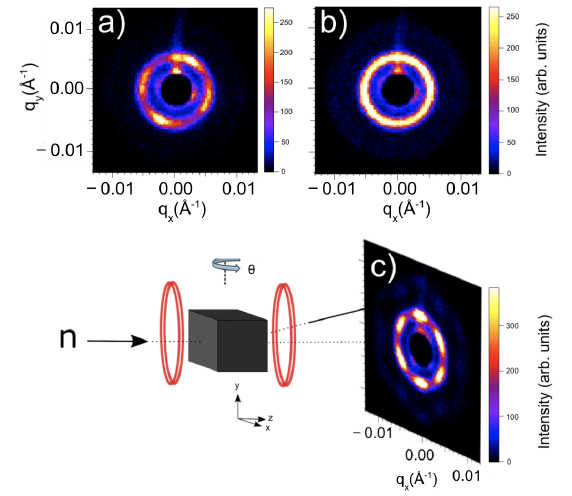
Figure 8. SANS images showing the disordered helical ground state at room temperature in zero field ( a ); the initial scattering ring for disordered skyrmion domains at 310 K in a magnetic field of 250 Oe ( b ); a schematic of the symmetry-breaking field rotation setup; and the SANS image after 30 rotations of the rotation sequence at 310 K in a field of 250 Oe ( c ). The increased intensity/preferential smearing of the peaks in the top right and bottom left diagonals of the four-fold helical image elucidate the anisotropy direction for the crystal. A schematic of the rotation setup illustrates the neutron propagation direction (n) is in the z-direction. For the symmetry-breaking rotation sequence, the sample is rotated symmetrically in the xz plane about θ , with the magnetic field fixed in the